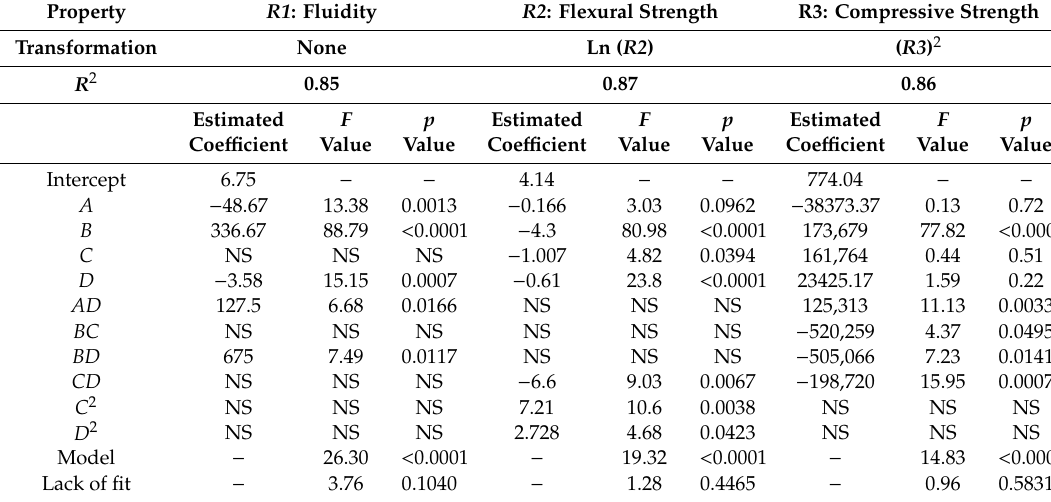
Table 7. Parameter estimation and ANOVA of response surface model.